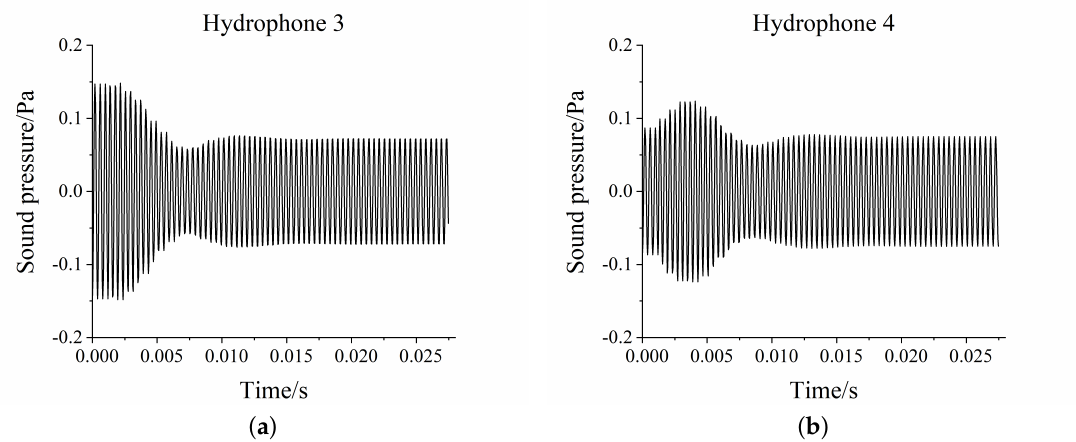
Figure 9. ( a ) The signal of hydrophone 3 changes with time in the impedance tube with steel sample at 2500 Hz. ( b ) The signal of hydrophone 4 changes with time in the sound tube with steel sample at 2500 Hz.